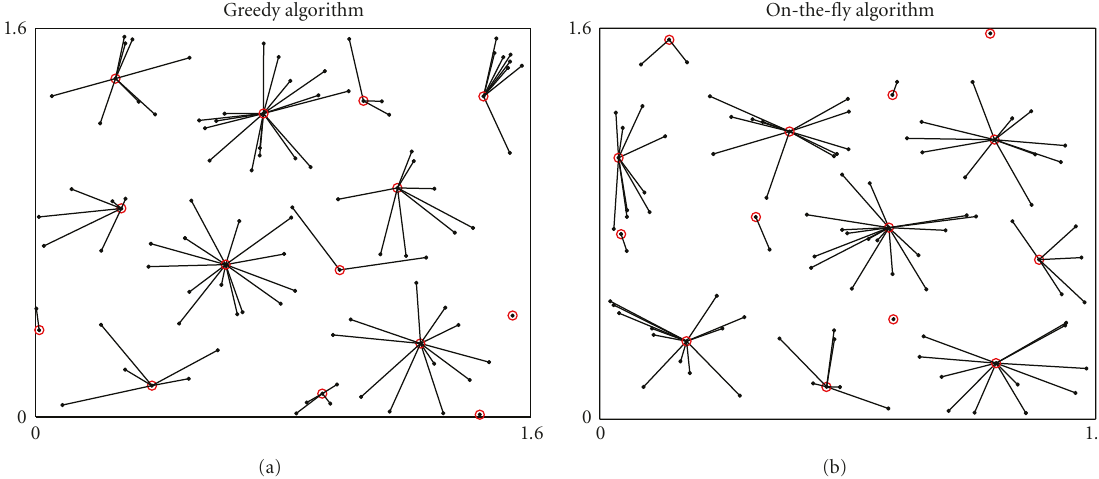
Figure 4: Cluster heads (red dots) and slaves (black dots) obtained for ν x = 0 . 30 using the greedy and the on-the-fly algorithms. The numbers of cluster heads obtained over 100 sensor nodes were equal to 14 and 18,